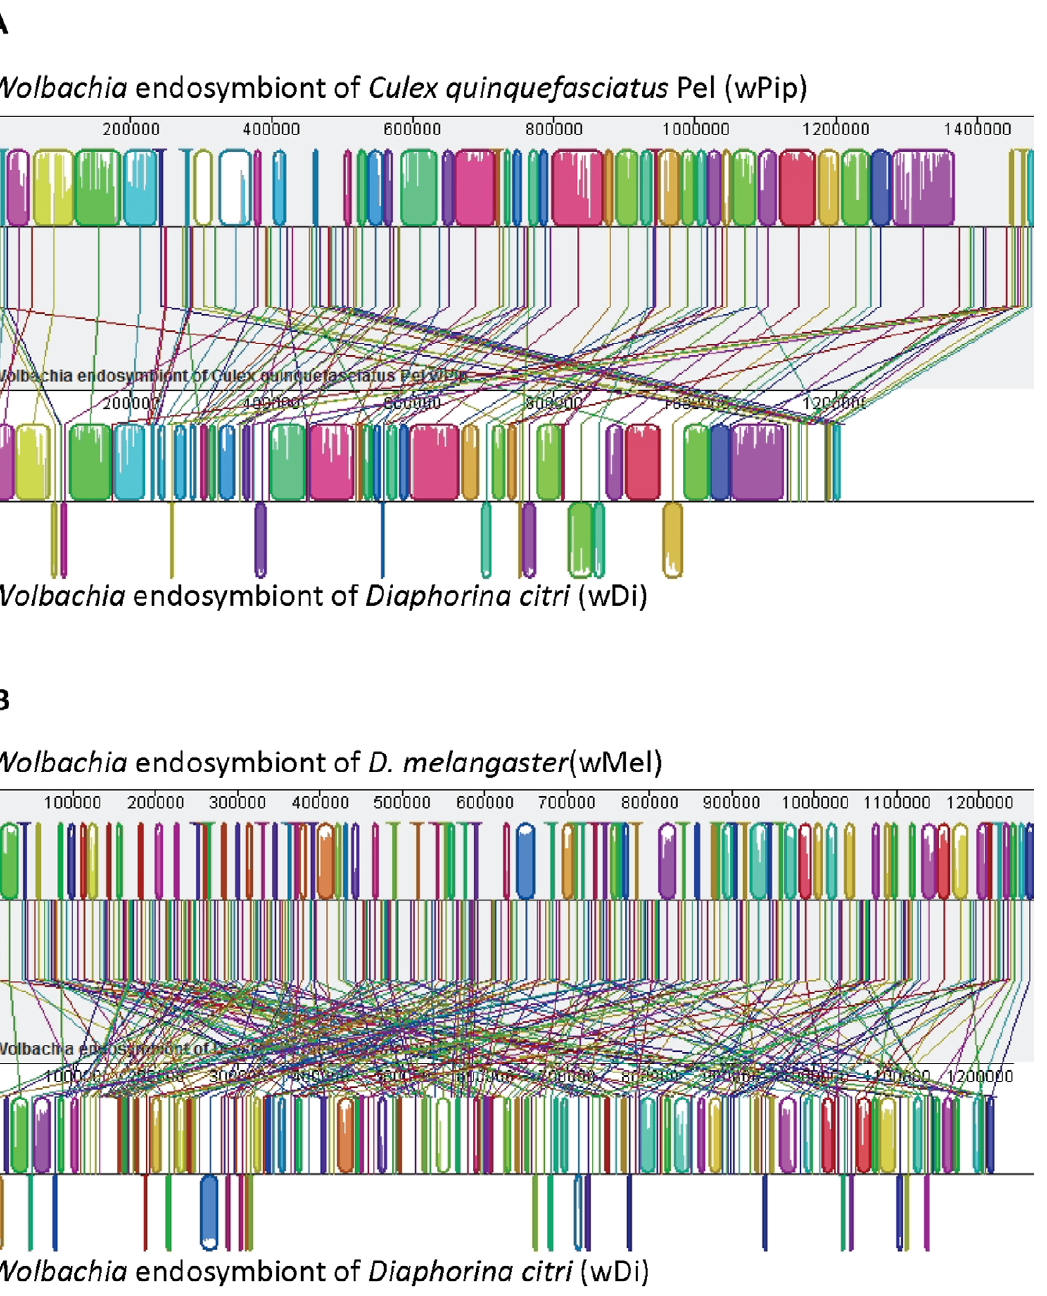
Figure 2. MAUVE alignment of Wolbachia endosymbiont of Diaphorinacitri (wDi) contigs with complete Wolbachia genomes. (A) Alignment with Wolbachia endosymbiont of Culex quinquefasciatus Pel (wPip) and (B) alignment with Wolbachia endosymbiont of D. melangaster (wMel).